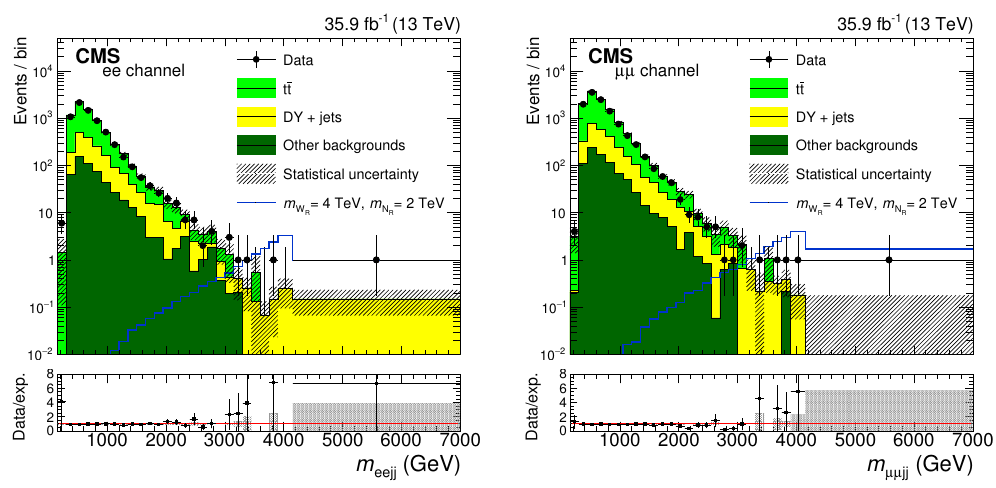
Figure 4 . The m ‘‘ jj distribution in the signal region for the electron (left) and muon (right) channel. The uncertainty bands on the simulated background histograms include only statistical uncertainties. The uncertainty bars in the ratio plots represent combined statistical uncertainties of data and simulation. The gray error band around unity represents the systematic uncertainty on the